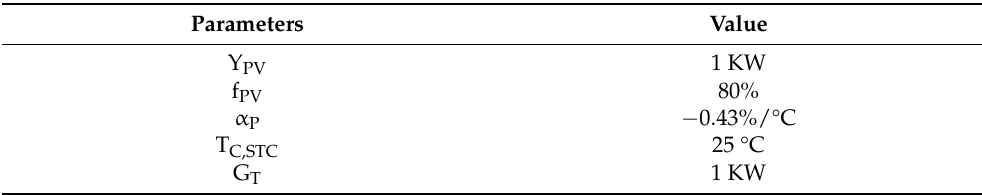
Table 5. PV array